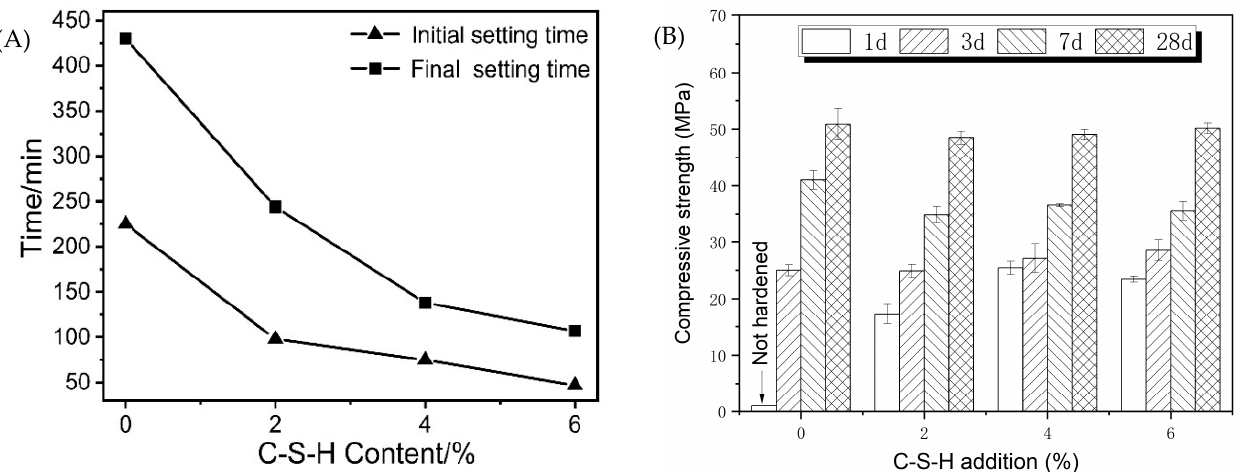
Figure 3. Properties of sodium carbonate-activated slag as a function of C-S-H seeds’ dosage: ( A ) setting times and ( B ) compressive strength.